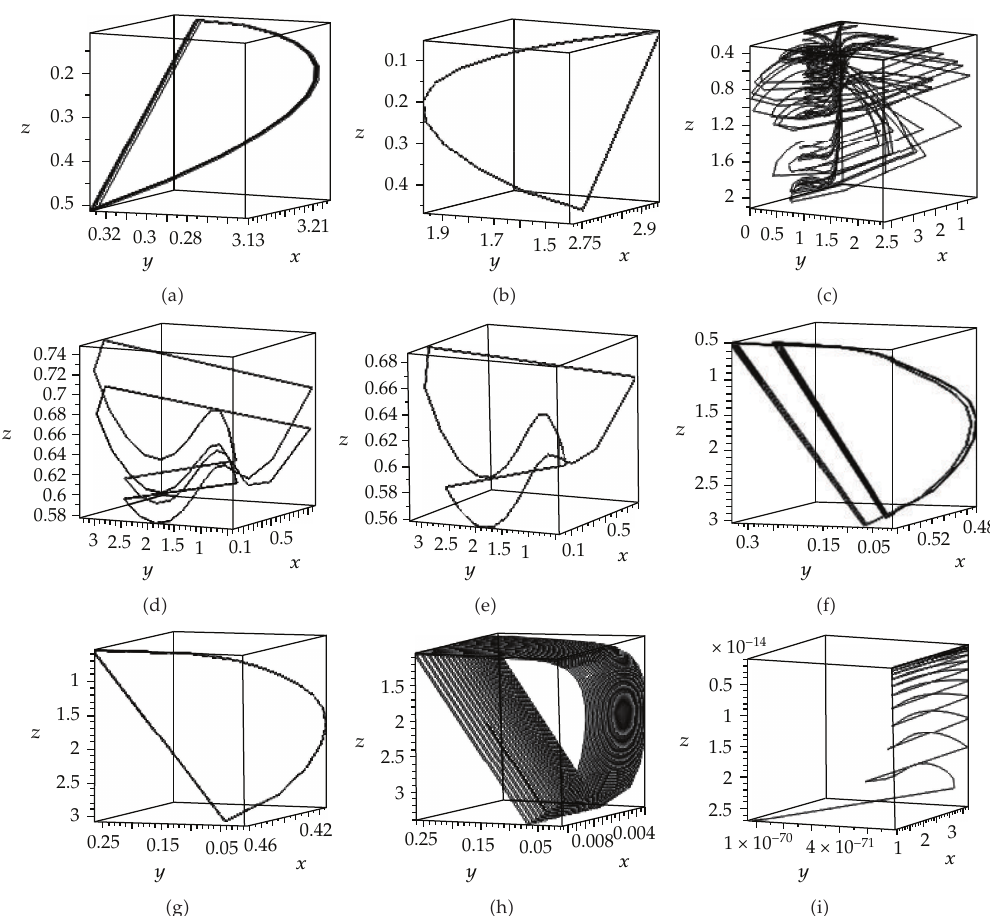
Figure 4: Periodic behavior and chaos corresponding to Figure 3: (cid:5) a (cid:6) phase diagram for p (cid:7) 0 . 05, (cid:5) b (cid:6) phase diagram for p (cid:7) 0 . 5, (cid:5) c (cid:6) phase diagram for p (cid:7) 2, (cid:5) d (cid:6) phase diagram for p (cid:7) 2 . 75, (cid:5) e (cid:6) phase diagram for p (cid:7) 2 . 85, (cid:5) f (cid:6) phase diagram for p (cid:7) 3 . 05, (cid:5) g (cid:6) phase diagram for p (cid:7) 3 . 15, (cid:5) h (cid:6) phase diagram for p (cid:7) 3 . 4, and (cid:5) i (cid:6) phase diagram for p (cid:7) 4 .